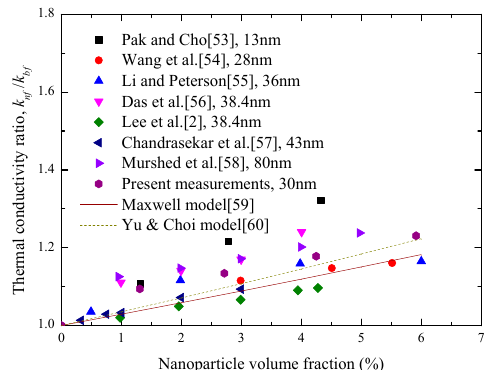
Figure 8. Variations of Al 2 O 3 -water nanofluids k nf / k bf with nanoparticle volume fraction at room temperature [2,53–60].